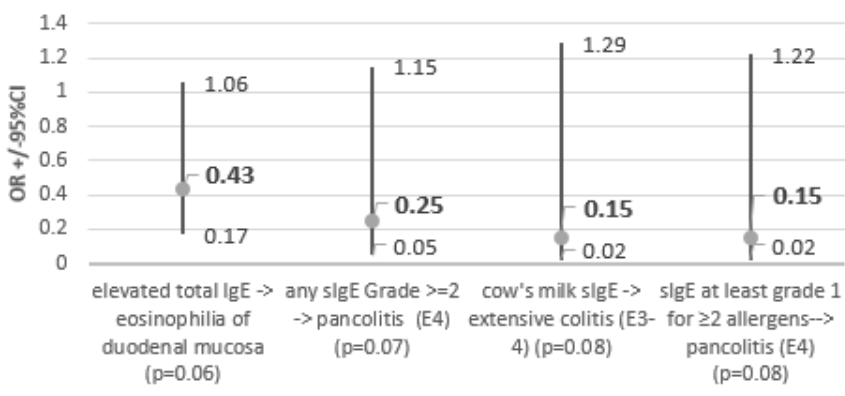
Figure 7. UC—odds ratios for negative correlations.